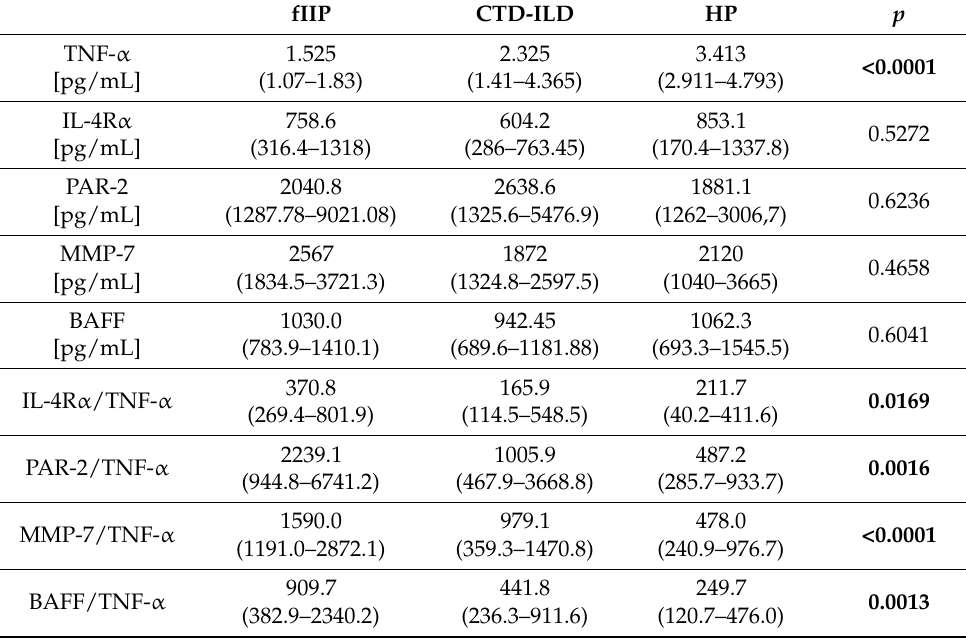
Table 3. Measured analyte concentrations in different IIPs subgroups.